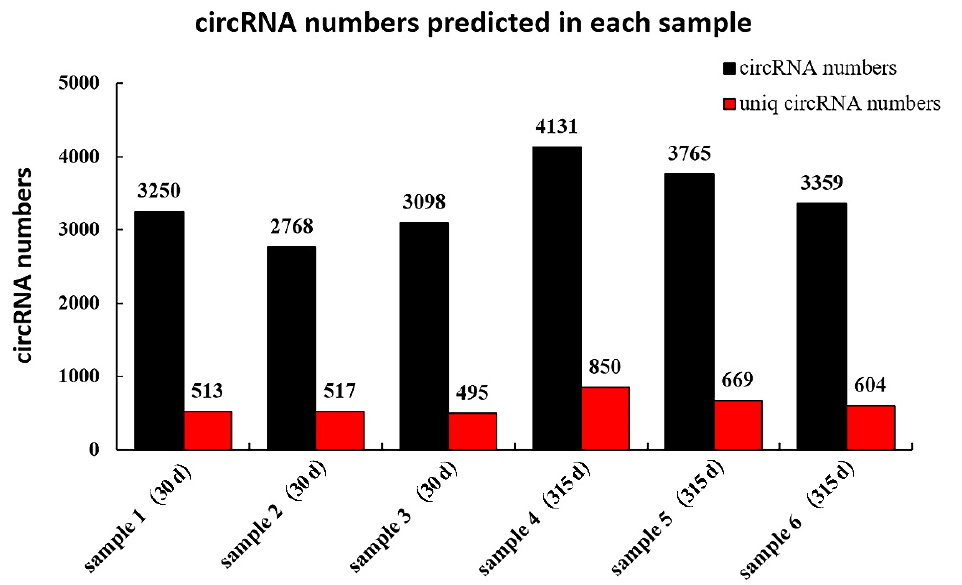
Figure 1. CircRNA numbers predicted in each sample. The vertical axis is the number of circRNAs; the horizontal axis shows the individual samples from cows on postpartum days 30 or 315; the numbers above each bar refer to the number of circRNAs predicted in each sample; the Uniq_circRNA_numbers refer to the number of circRNAs specifically predicted in each sample compared to other samples in the project.